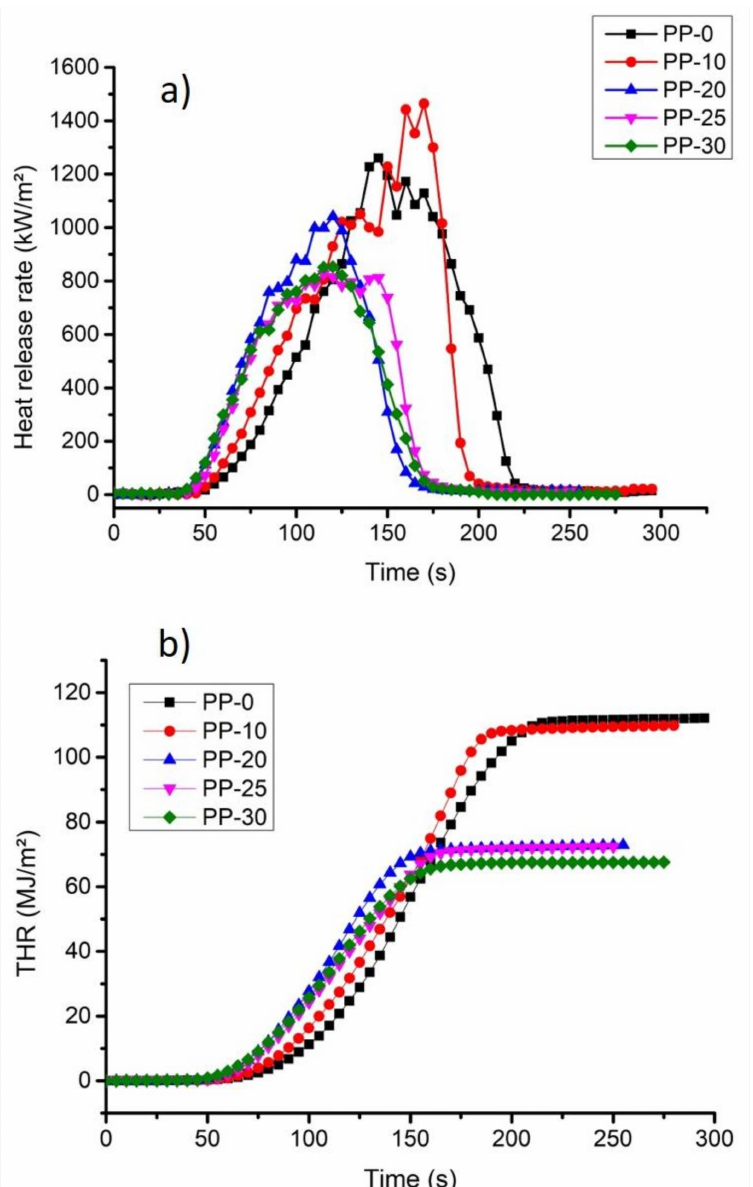
Figure 6. Calorimetric measurements: ( a ) comparison of the peaks of the heat release rate (HRR) and ( b ) THR curves for the